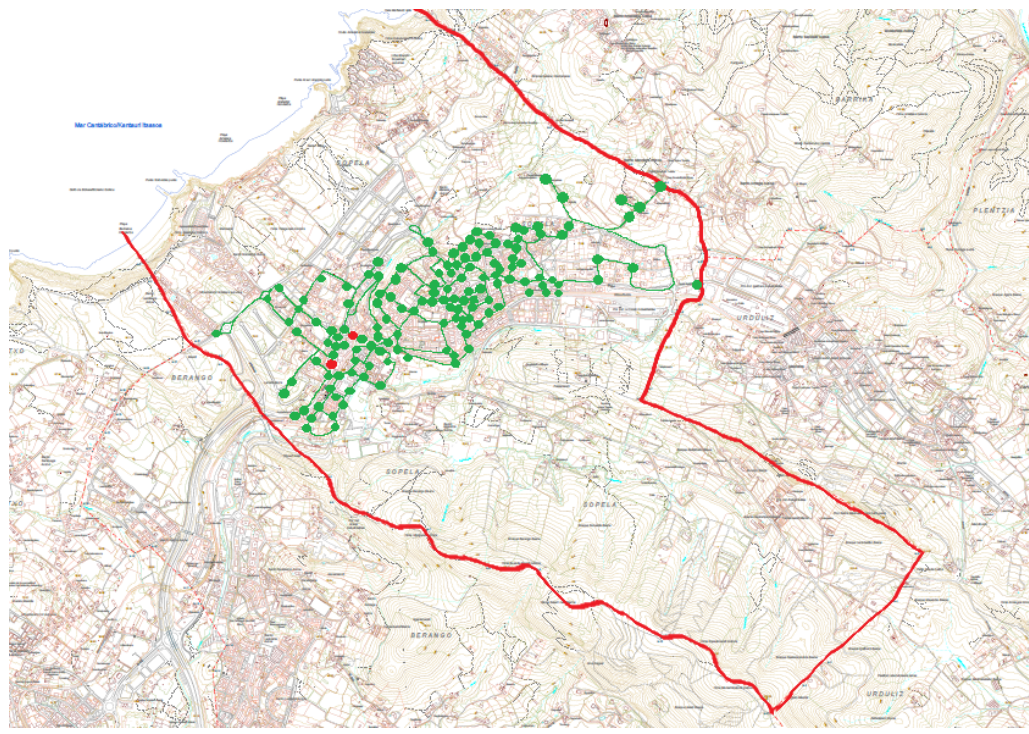
Figure 6. Smallest route obtained for problem n =